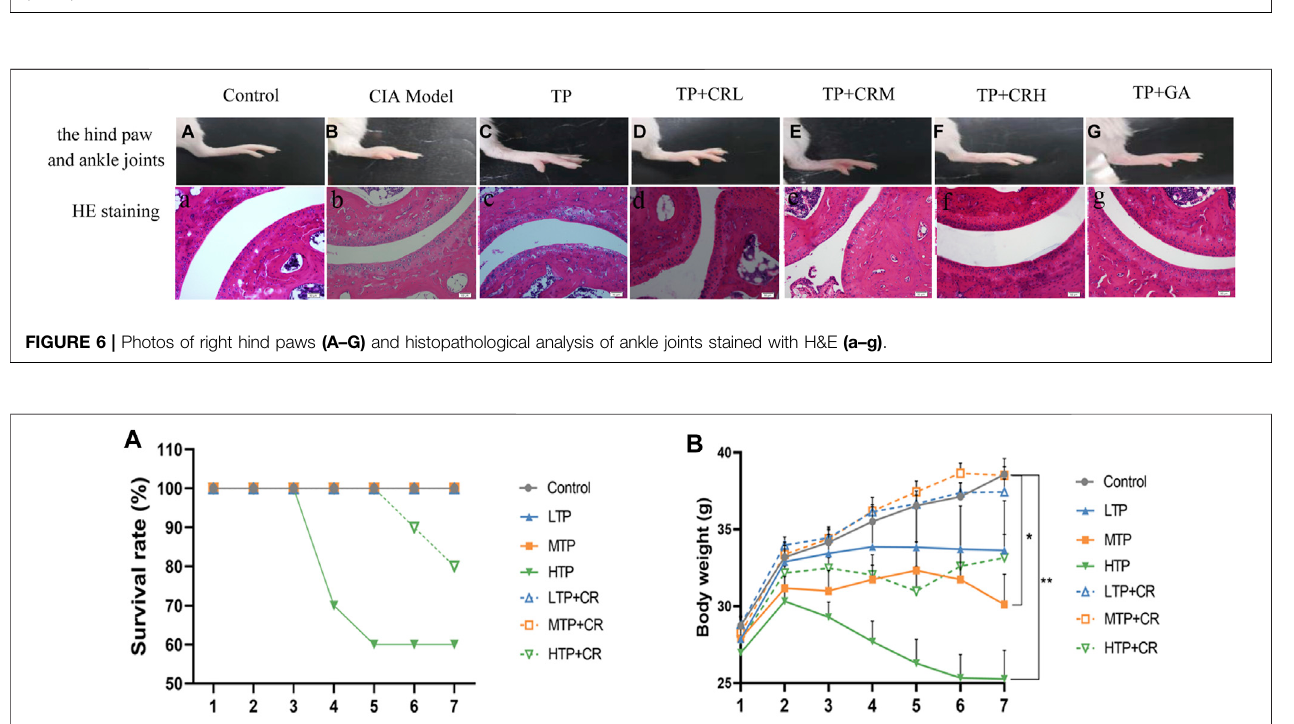
FIGURE5| Quantitation of proin fl ammatory cytokines (A) TNF- α ; (B) IL-1 β ; (C) IL-6 and anti-type II collagen antibody (D) in serum of each group using ELISA. (n = 6).